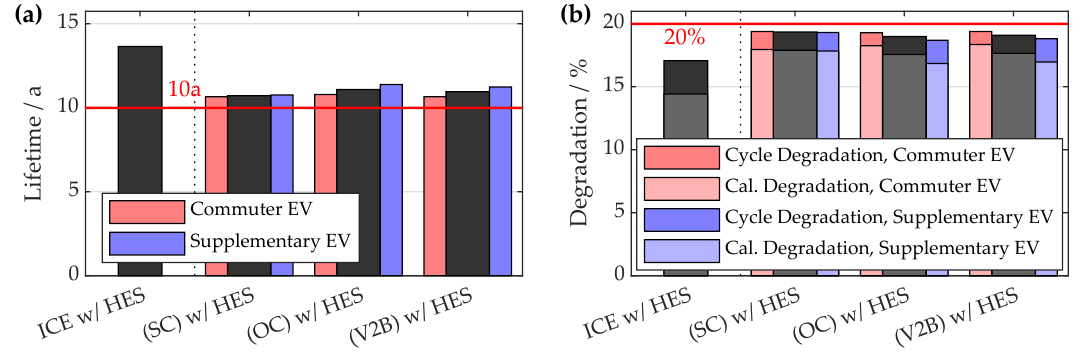
Figure 9. ( a ) Modelled lifetime of the lithium iron phosphate (LFP) home energy storage system (HES) with a nominal capacity of 9kWh and ( b ) calendar and cyclic degradation during ten years of operation, with the end of life (EOL) condition of 80% remaining capacity. The dark-grey column represents the average